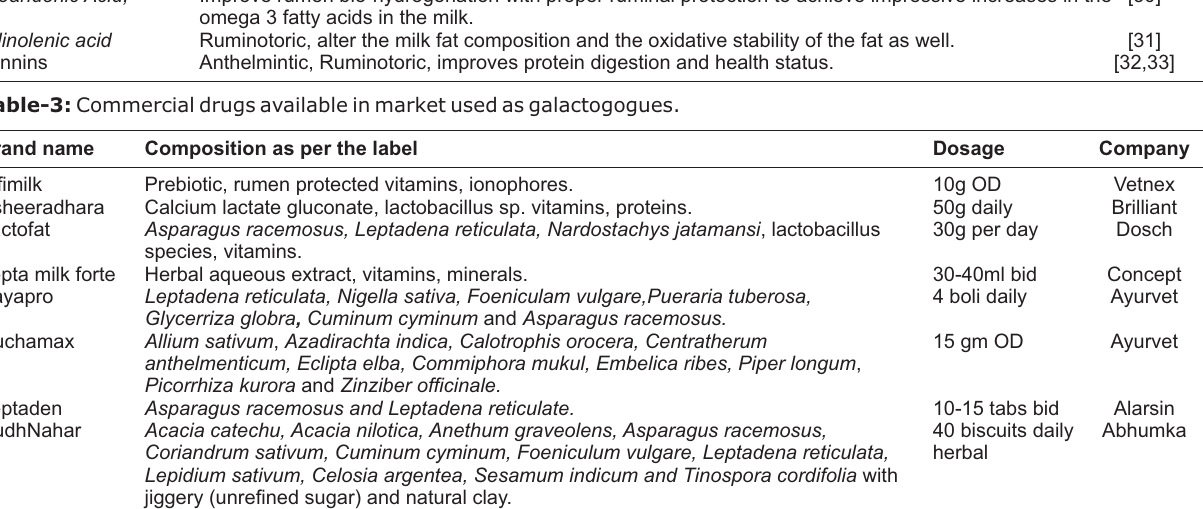
Table-2: Phytochemical groups with effect on galactopoiesis [26-33]. Lead compound Help in letting down of milk.